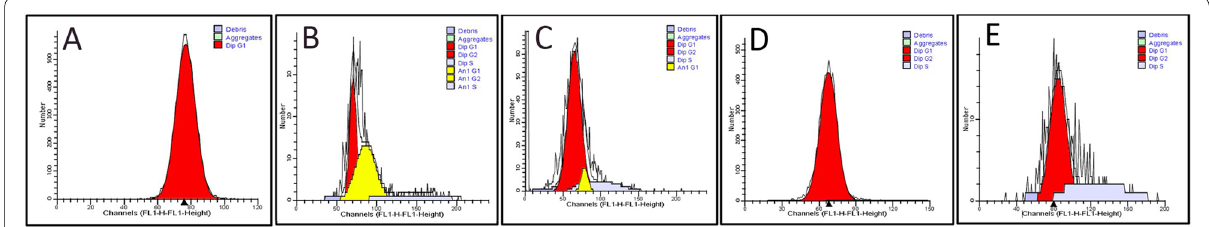
Fig. 5 Flow cytometry analysis of the buccal mucosa DNA. DNA frequency histogram of A diploid peak obtained from the normal oral HBP mucosa, showing single G0/G1 peak and no SPF cells. B Aneuploid malignant tumors in group 2A showing hyperdiploid ( DI (12.82%). C Aneuploid malignant tumors in group 2B showing hyperdiploid ( DI low SPF (1.25%) and diploid peak. E Animals in group 2A, showing high SPF (33.26%) and diploid